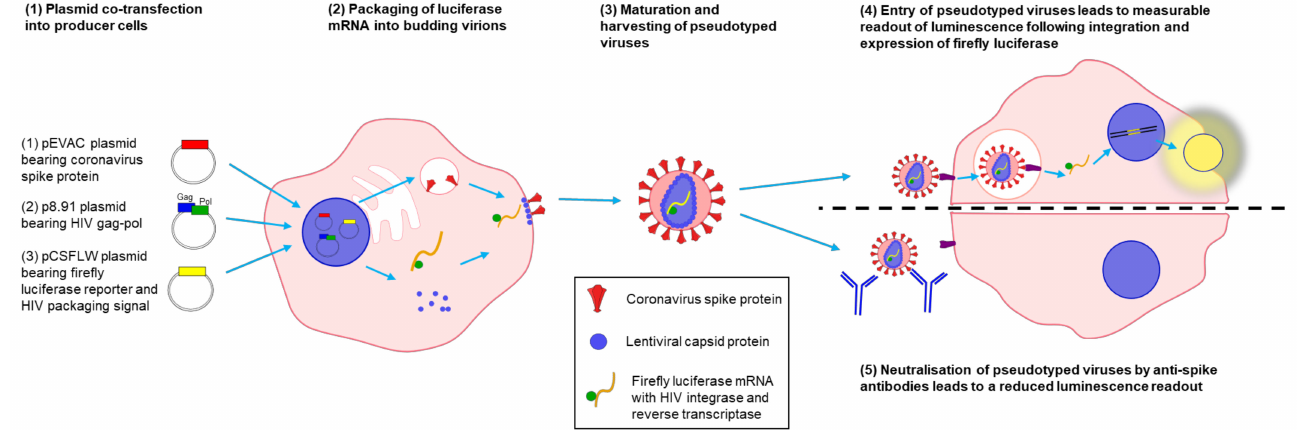
Figure 4. Schematic representing pseudotyped virus (PV) production and use in PV neutralization assays. Producer cells were co-transfected with plasmids encoding a coronavirus spike protein, a lentiviral gag-pol construct and the pCSFLW firefly luciferase reporter. The lentiviral capsid assembled into a PV core and packaged the pCSFLW reporter construct (consisting of the firefly luciferase coding sequence flanked by lentiviral LTRs), before budding from the plasma membrane and acquiring an outer membrane studded with coronavirus spike proteins. After spike-mediated entry into target cells, the pCSFLW reporter was integrated and expressed, leading to measurable luminescence from successfully transduced target cells. Neutralization of PVs by anti-spike antibodies following incubation with human sera can be measured as a reduction in luminescence output after target cell